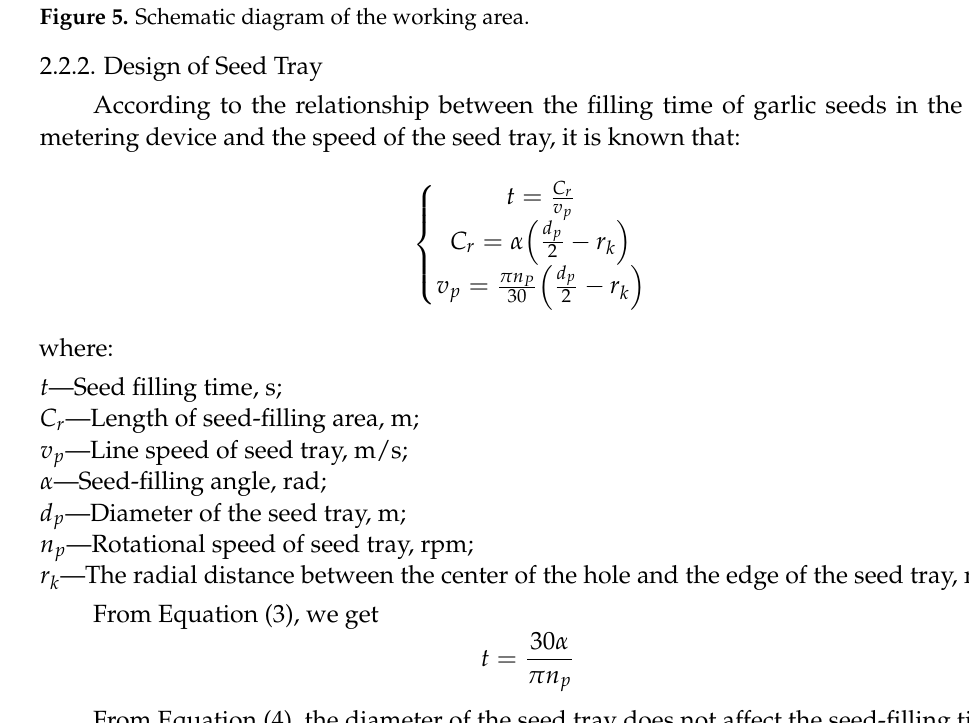
Figure 5. Schematic diagram of the working area.